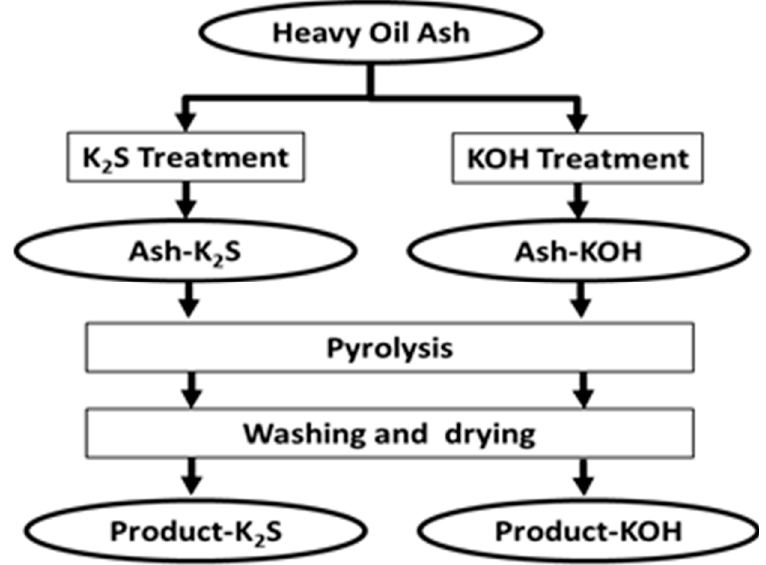
Figure 1. Flowchart for preparation of the product.